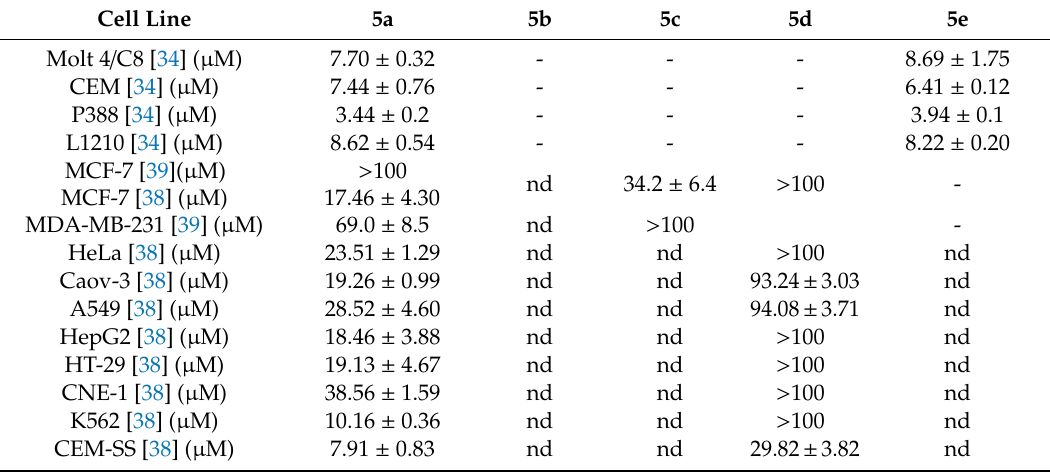
Figure 7. Chemical structures of 4-aminochalcone derivatives with chloro substitutions on ring B. Table 5. Inhibitory effect of compounds 5a – c and 5e against the human Molt 4/C8, CEM T-lymphocytes, murine P388, L1210, estrogen-receptor-positive breast cancer cells MCF-7, and the triple-negative breast cancer (TNBC) cells MDA-MB-231.